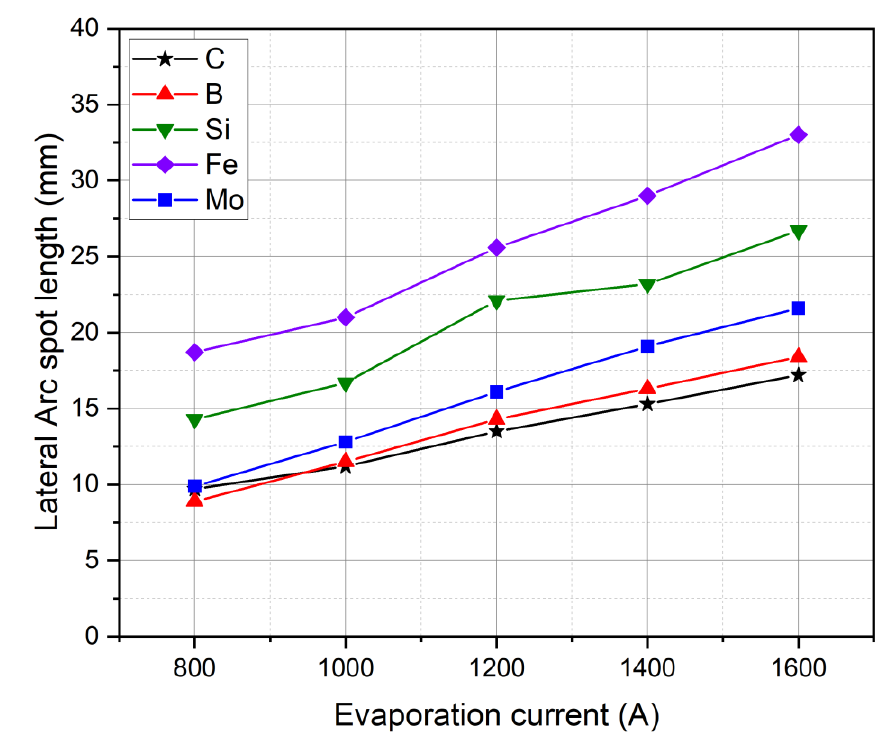
Figure 8. Lateral size of arc spot traces on the cathode surface in relation to the evaporation